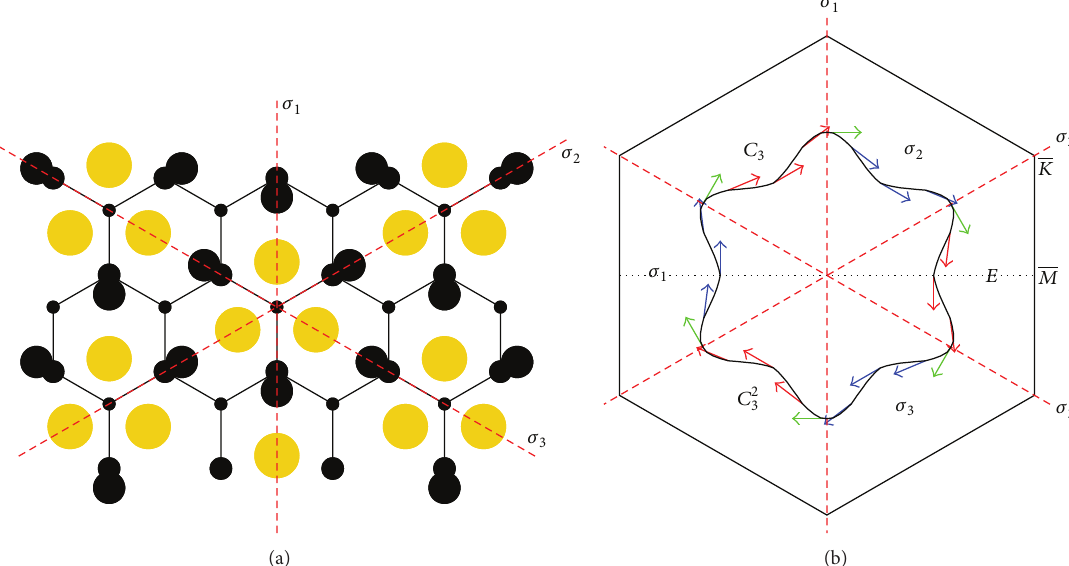
Figure 5: (a) Real-space top view of the CHCT structure with three mirror-plane symmetries 𝜎 1 , 𝜎 2 , and 𝜎 3 shown as red, dashed lines. (b) The surface Brillouin zone of the √3 × √3 unit cell. The red, dashed lines show the orientation of the three mirror planes in the reciprocal space. The six symmetry operations of the 𝐶 3 V group transform one of the irreducible parts of the BZ, called 𝐸 , into other irreducible parts. A possible constant-energy contour is shown as a solid line within the BZ together with a possible spin texture along the contour shown as color arrows. Red color of arrows corresponds to one possible 𝑧 direction of spin vectors; blue color corresponds to the opposite direction. The green color of spin vectors along the Γ − 𝐾 lines means fully planar